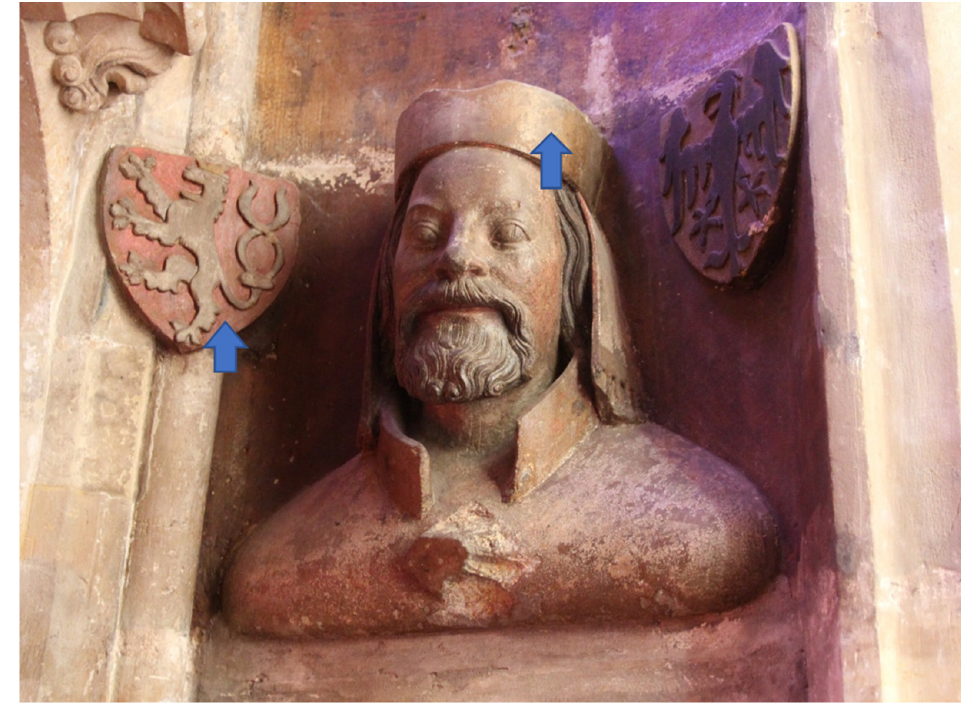
Figure 2. Bust—Charles IV, arrows indicate measured positions.